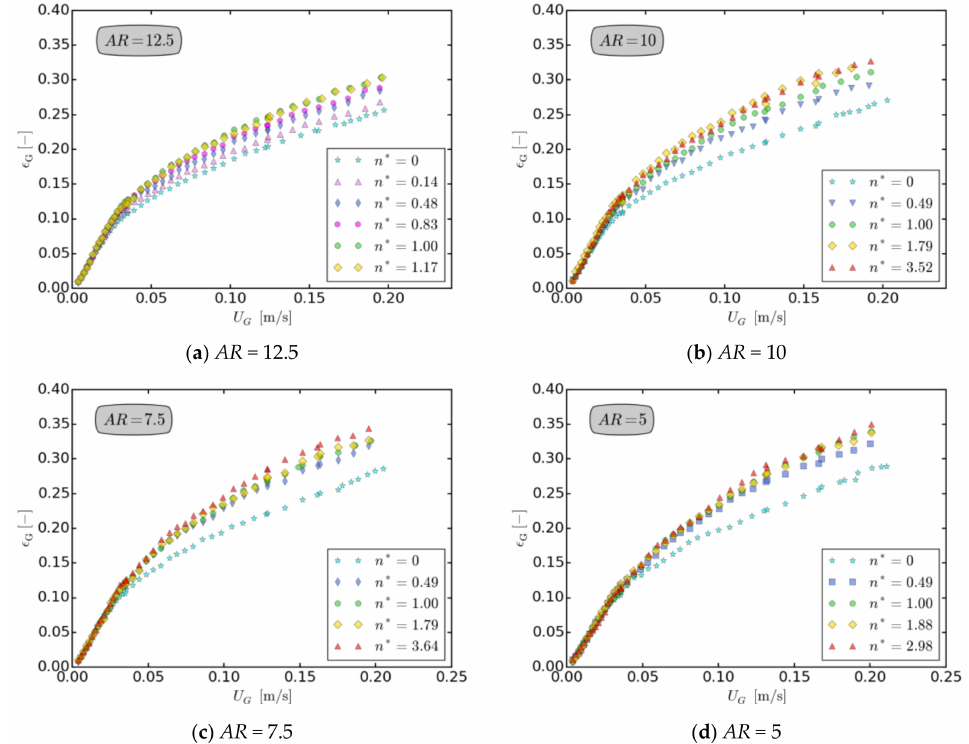
Figure 23. Influence of NaCl on gas hold-up (batch mode)—data from ref. [28]. Organic